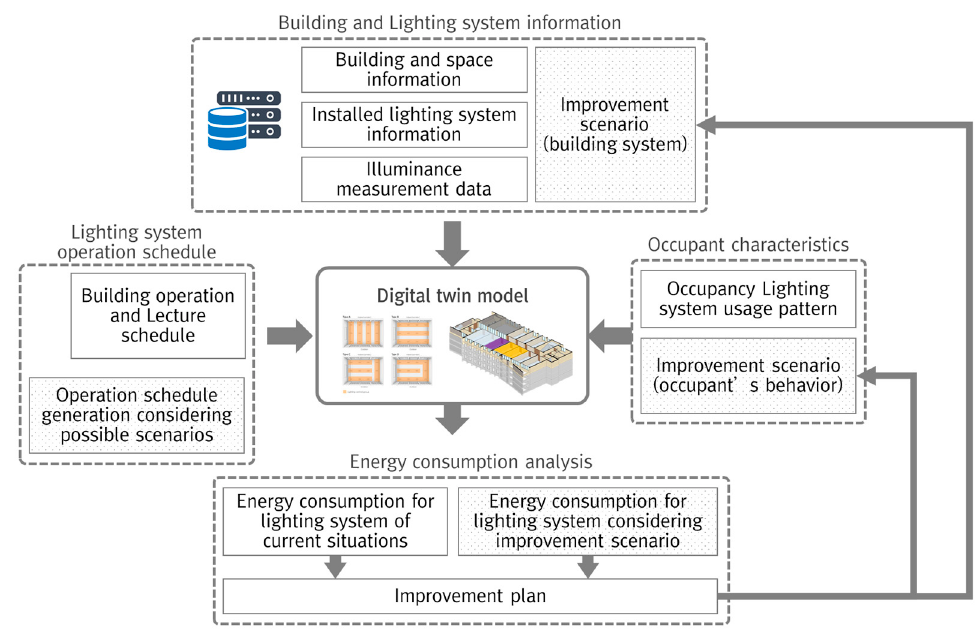
Figure 1. Flowchart of the proposed evaluation framework.